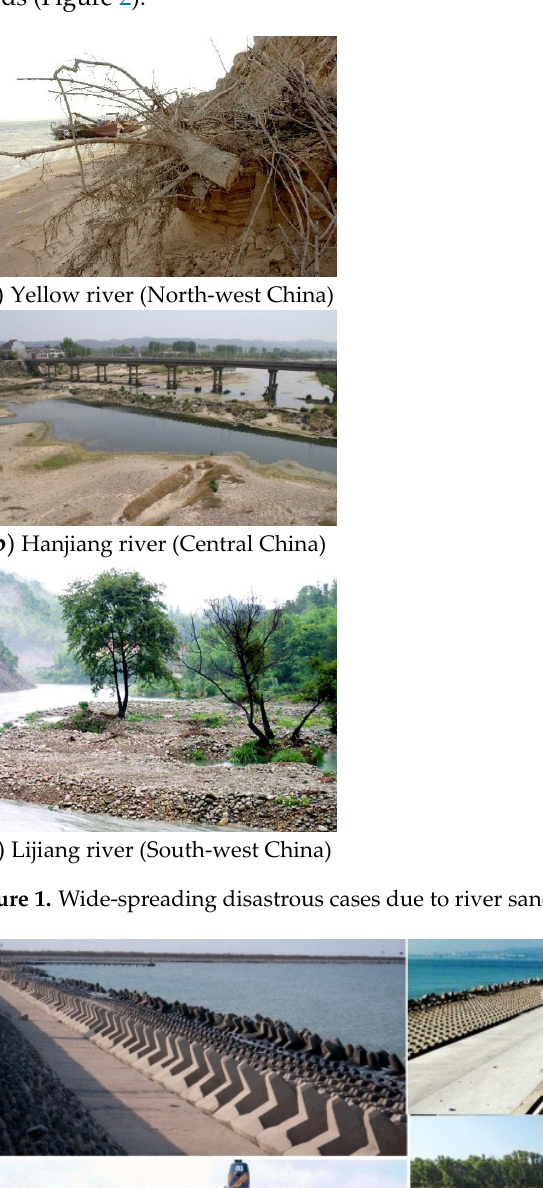
Figure 1. Wide-spreading disastrous cases due to river sand excavation in China.